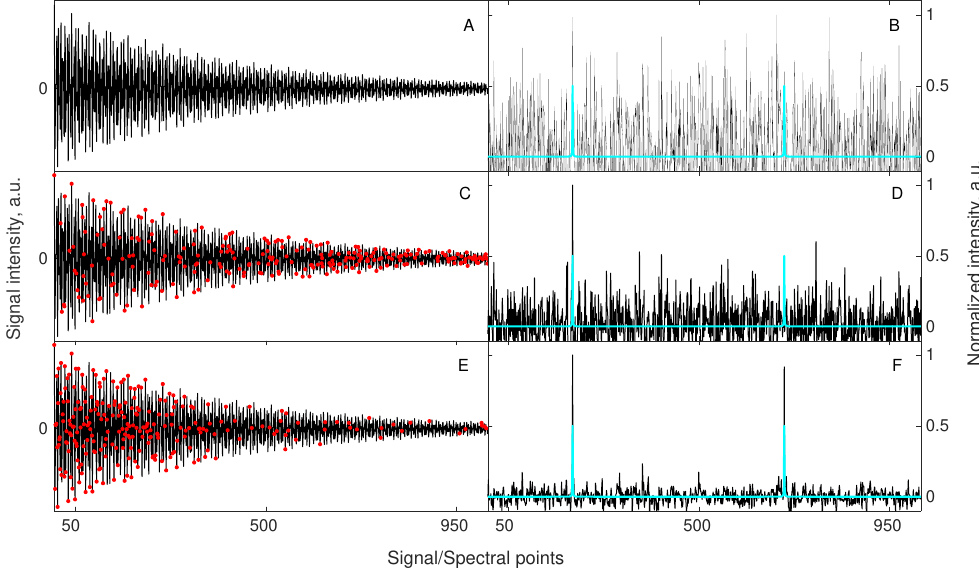
Figure 4. A simulation illustrating the benefit of relaxation-matched non-uniform sampling on signal reconstruction. A signal of 1024 points length containing 2 components of equal amplitudes ( A ) was artificially contaminated with a white noise such that peaks in a corresponding spectrum ( B ) were hardly visible. A blue spectrum imposed in ( B , D , F ) is obtained from the noiseless signal ( A ) to mark the correct positions of the hidden peaks (for better visualization, the peak intensities in blue spectra are normalized to half-intensity of the maximum peak in the corresponding black spectrum). The same 2-component signal was sub-sampled to 256 random points ( C ), and 256 points selected according to the relaxation-matched probability ( E ). A continuous black line in ( C , E ) stands for the full signal, whereas red markers correspond to sub-sampled points. Both sub-sampled sets of points were used for reconstruction using 40 iterations of the IRLS algorithm. Importantly, the sub-sampled signals ( C , E ) were injected into a noise being 2 times lower than for signal A. This is due to a fact that 256 points can be acquired with 4 times more scans keeping the same total experimental time, thus SNR of the acquired samples will be 2 times higher. A reconstructed spectrum ( D ), obtained from random non-uniform sampling strategy ( C ) shows no improvement, while the spectrum ( F ) obtained from a relaxation-matched non-uniform sampling strategy ( E ) indicates a significant improvement of the visibility of peaks. As described above in the text, the relaxation-matched sampling ( E ) strategy leads to better results in such cases as more samples are collected for the initial part of the signal, where SNR is